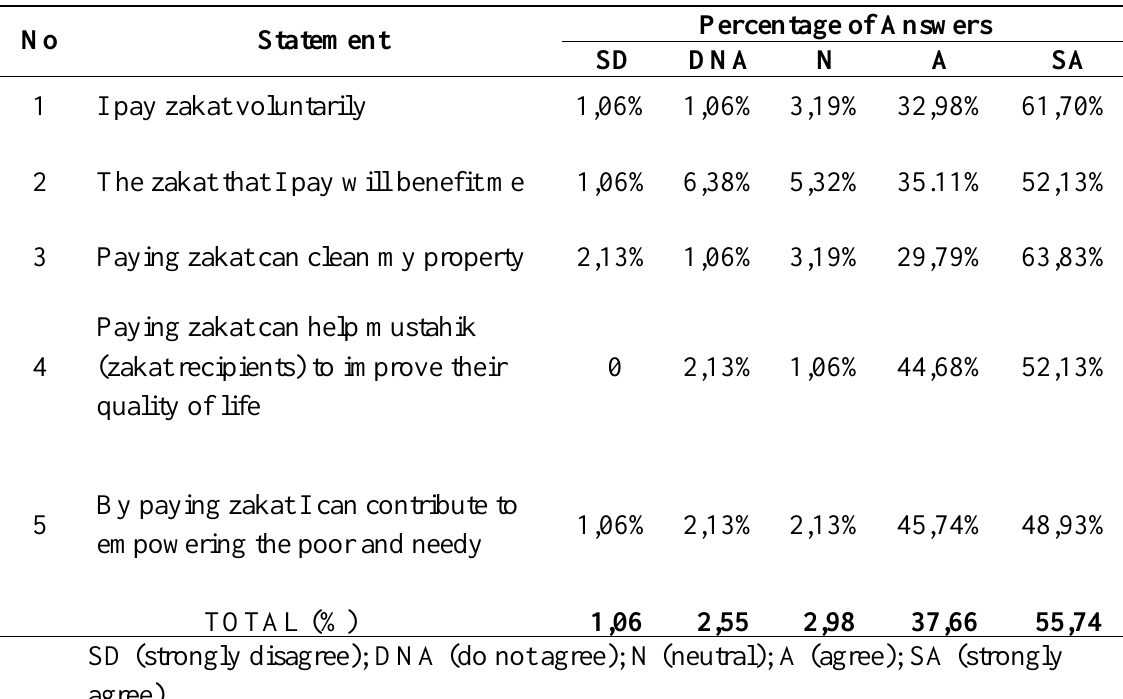
Table 3: Description of Attitude Variables